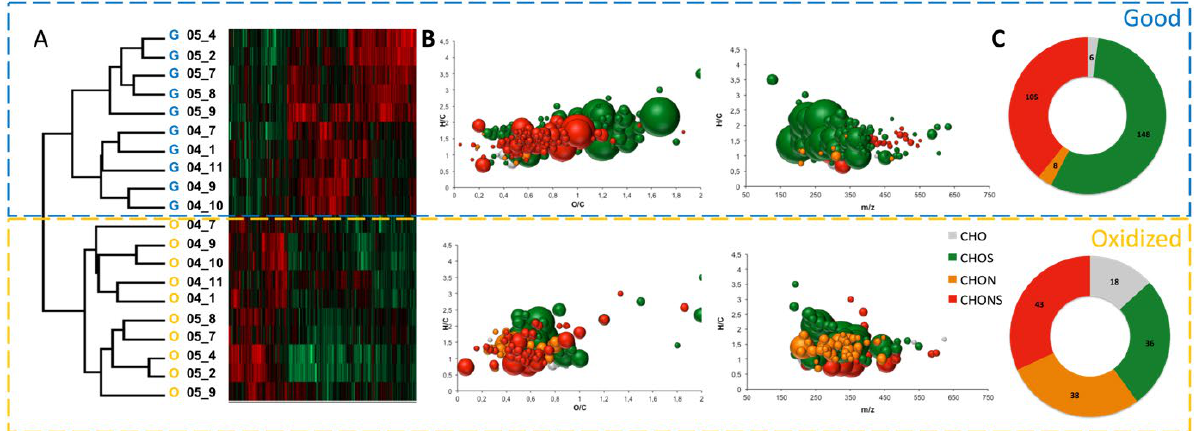
Figure 2. Characteristic (-)ESI FT-ICR-MS-derived molecular formulas elaborated by hierarchical cluster analysis. ( A ) Hierarchical cluster analysis of the assigned (-)ESI FT-ICR-MS-derived molecular formulas observed in wines from 2004 (04) and 2005 (05) vintages and different vineyard plots (1; 2; 4; 7; 8; 9; 10; 11), according to their oxidative character (O: oxidized; G: good). ( B ) Van Krevelen diagrams depict the most representative characteristic molecular formulas for the two main subclusters. Van